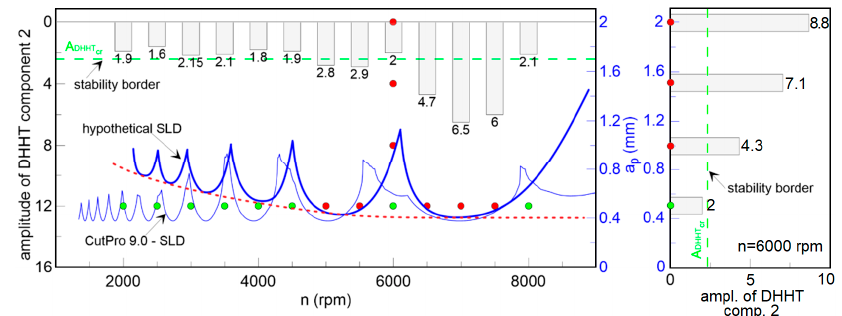
Figure 11. The amplitude of DHHT component 2 (left axis) and the stability lobes diagram (right axis) as a function of rotational speed and depth of cut.